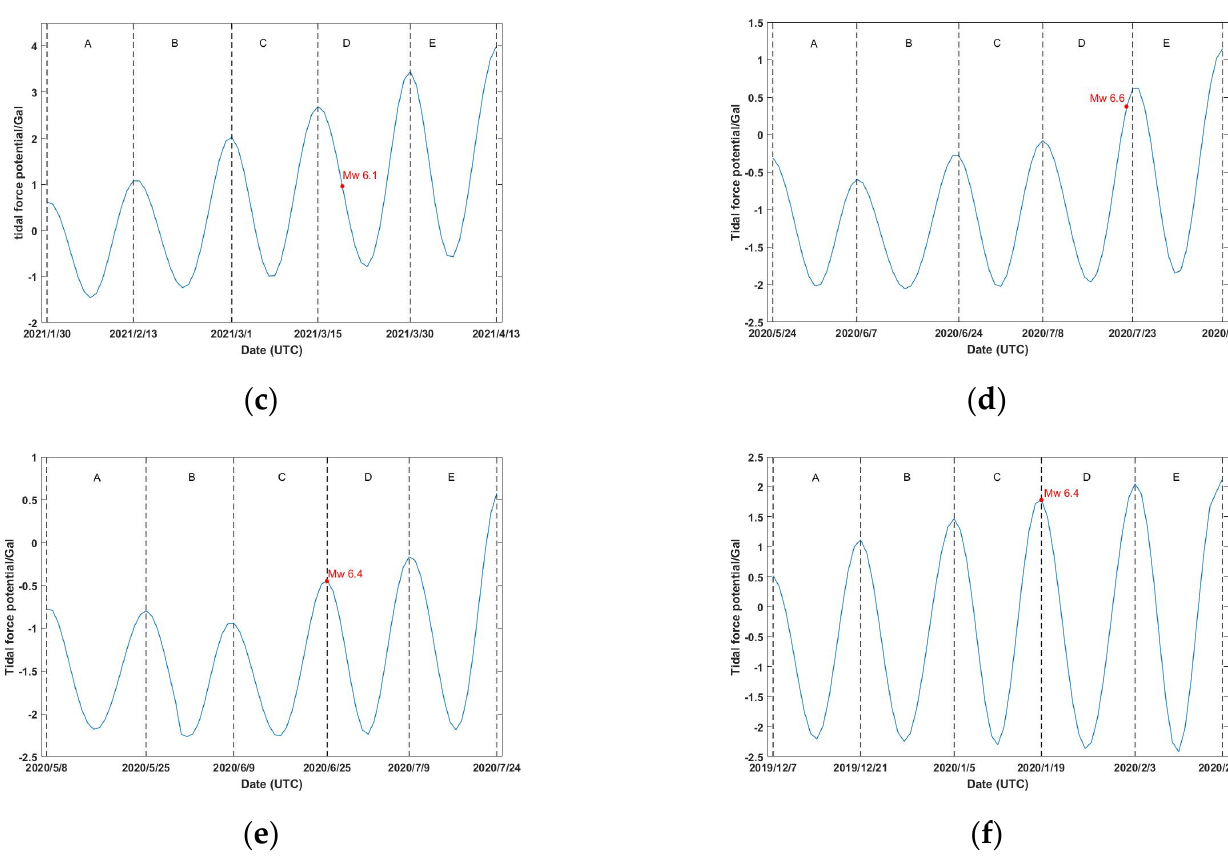
Figure 2. The change in tidal force potential for earthquake in ( a ) Maduo, ( b ) Yangbi, ( c ) Biru, ( d ) Nima, ( e ) Yutian, ( f ) Jiashi. The red points are the dates of earthquakes. Table 3. The date range of each period for the studied earthquakes. Earthquake Period A Period B Period C Period D